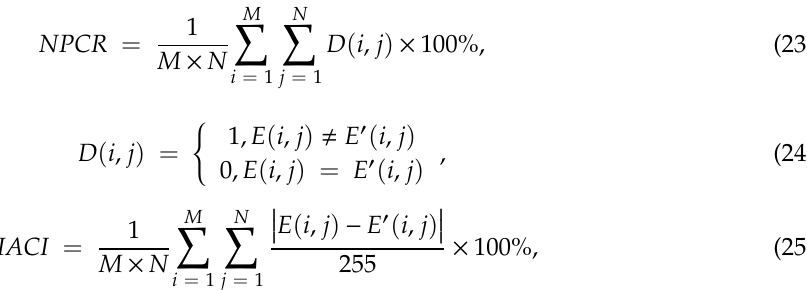
Table 3. The values of the number of pixel change rate (NPCR) and unified average changing intensity (UACI).